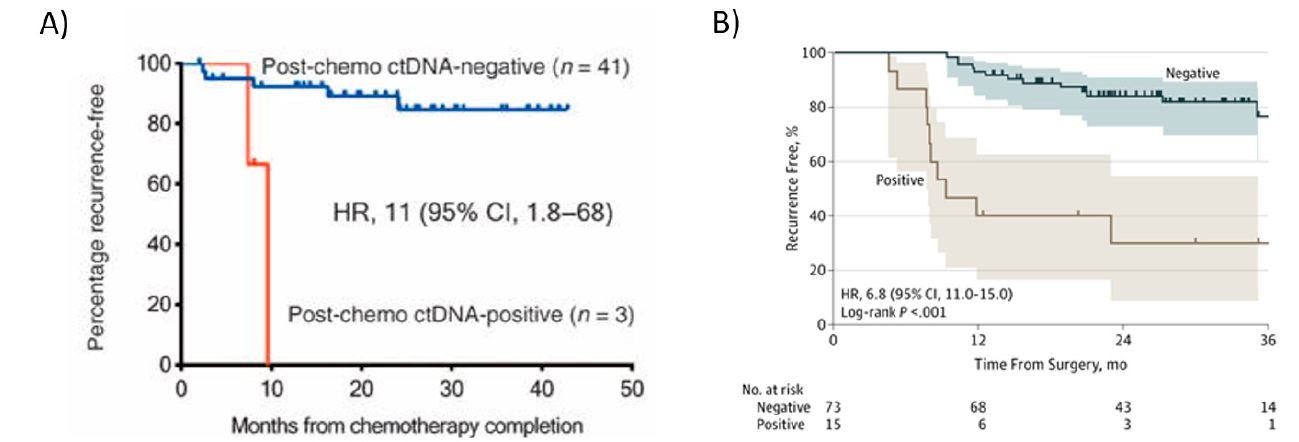
Figure 5. Kaplan–Meier estimates of recurrence-free interval according to ctDNA in colon cancer patients after adjuvant chemotherapy. ctDNA status after adjuvant chemotherapy in patients with colon cancer. ( A ) Stage II; ctDNA positivity immediately after completion of chemotherapy was associated with poorer RFS. From Tie et al., 2016 [21]. ( B ) In Stage III. From Tie et al. [123].